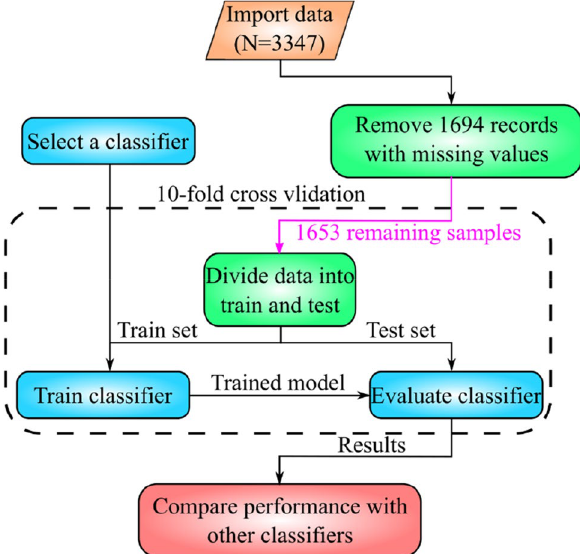
Figure 1. Flowchart of data analysis with different classifier